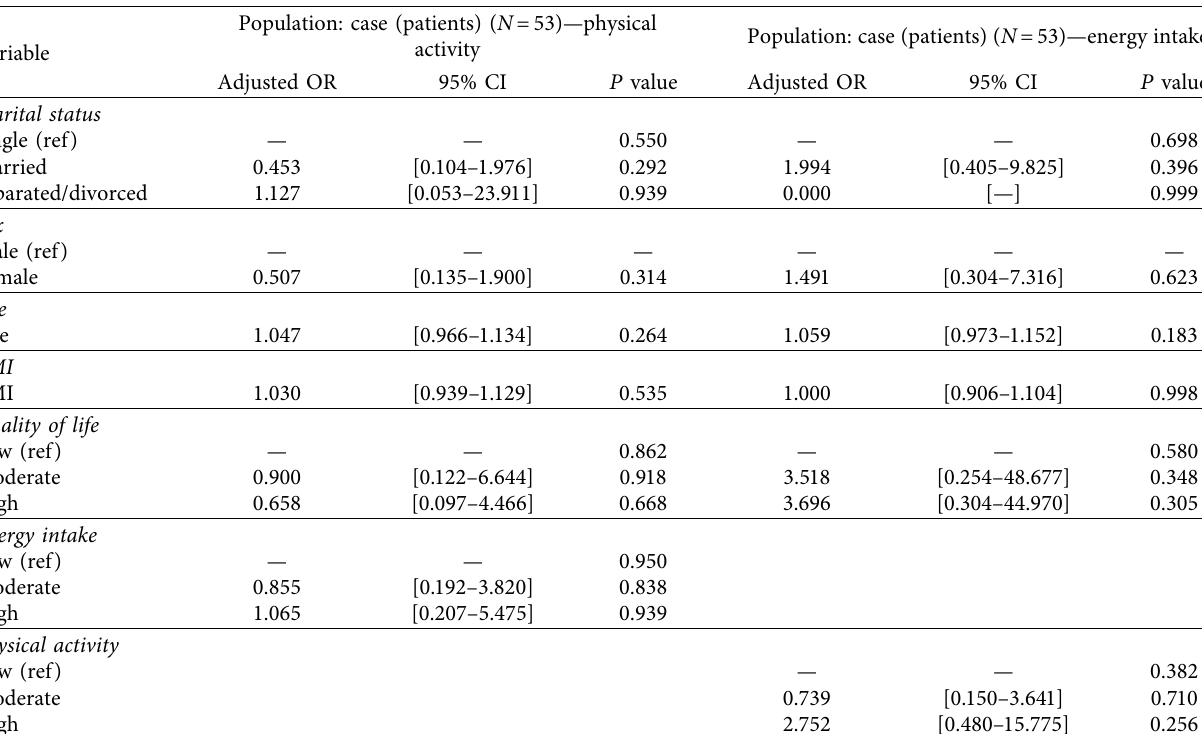
Table 5: Physical activity/energy intake—bariatric